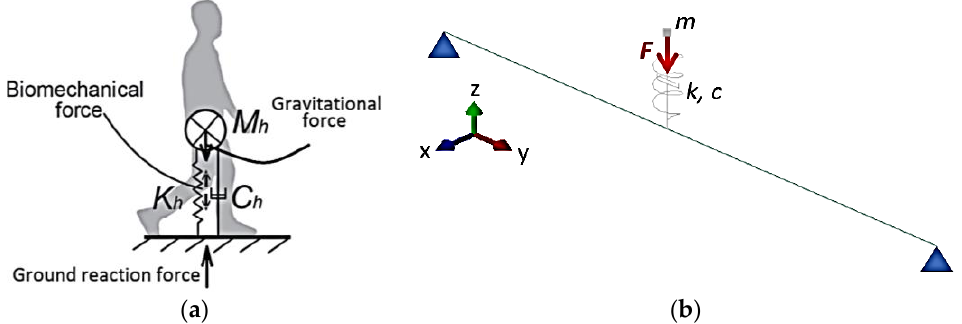
Figure 1. Biodynamic pedestrian model: ( a ) schematic representation of Spring-Mass-Damper (SMD), Single Degree of Freedom (SDOF) model (figure reprinted from [8] with permission from Elsevier©, copyright license number agreement 5458701302374, December 2022) and ( b ) example of presently developed numerical model for Human-Structure Interaction (HSI) analysis.